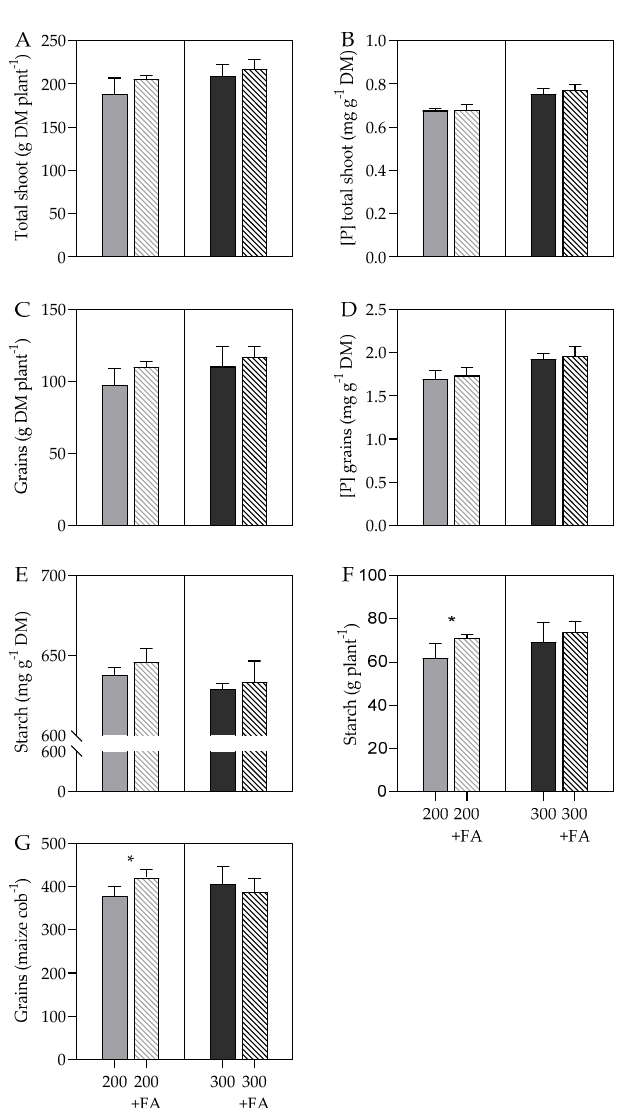
Figure 6. Total shoot ( A ) dry matter in g plant − 1 , ( B ) phosphorus concentration (P) in mg g − 1 dry matter, ( C ) grain dry matter in g plant − 1 , ( D ) grain phosphorus concentration (P) in mg g − 1 dry matter, ( E ) starch concentration in mg g − 1 dry matter, ( F ) starch content in g plant − 1 , and ( G ) number of grains per maize cob at maturity (BBCH 89). Plants were cultivated with 200 mg P soil fertilization (200) with additional foliar application (FA) (200 + FA) or with 300 mg P soil fertilization (300) with additional foliar application (300 + FA). KH 2 PO 4 was used as foliar fertilizer and was applied at 35, 42, and 49 days after sowing. Bars represent means + SD ( n = 5). Asterisks indicate significant differ- ences between treatments of one fertilization level (Student´s t -test, p ≤ 0.05).